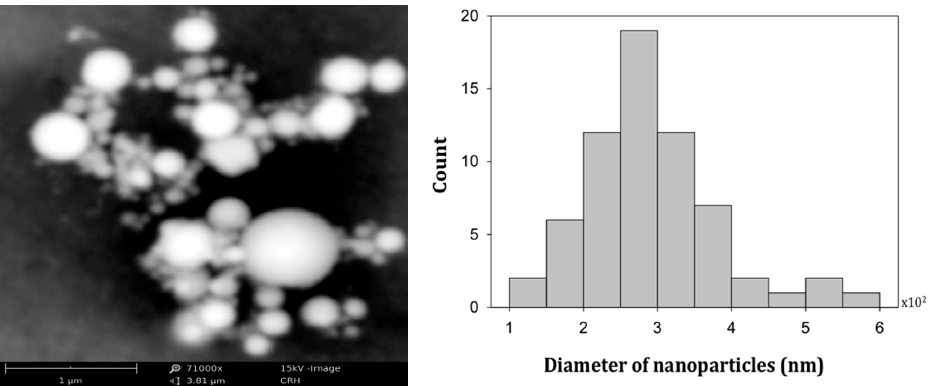
Figure 6. SEM images of magnification of TiFe 2 O NPs dried over Si substrate and size histogram.